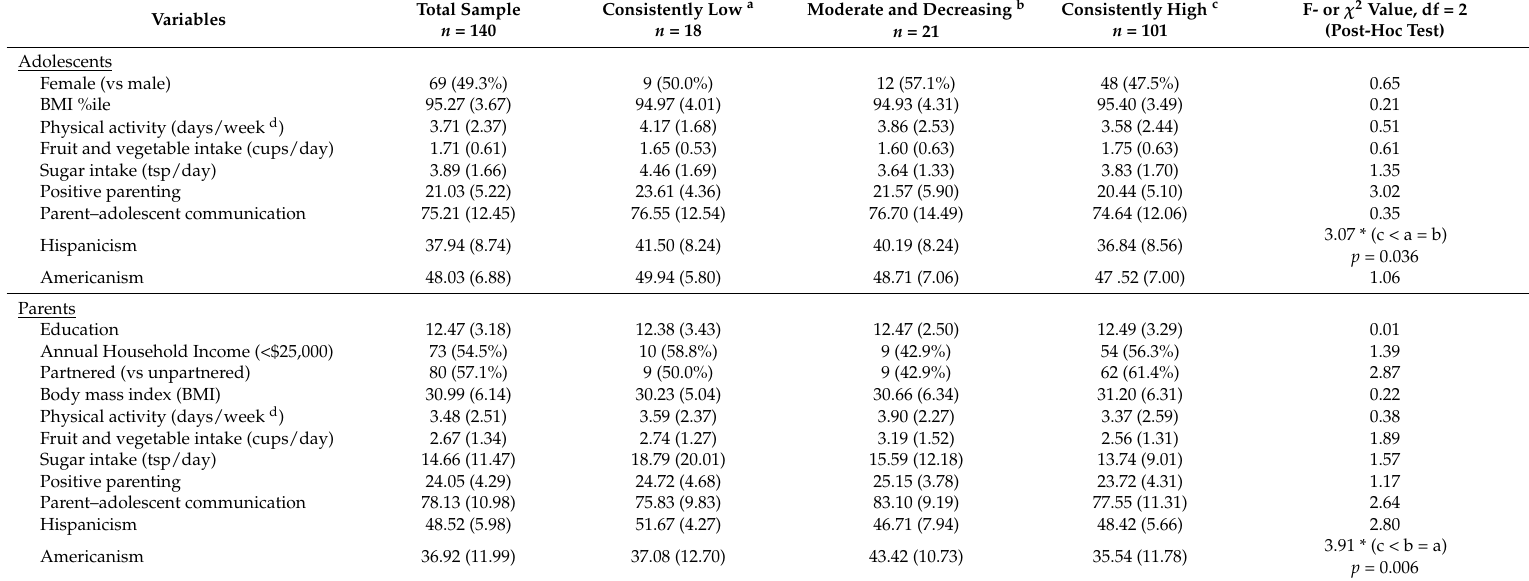
Table 4. Profiles of Three Classes of Attendance